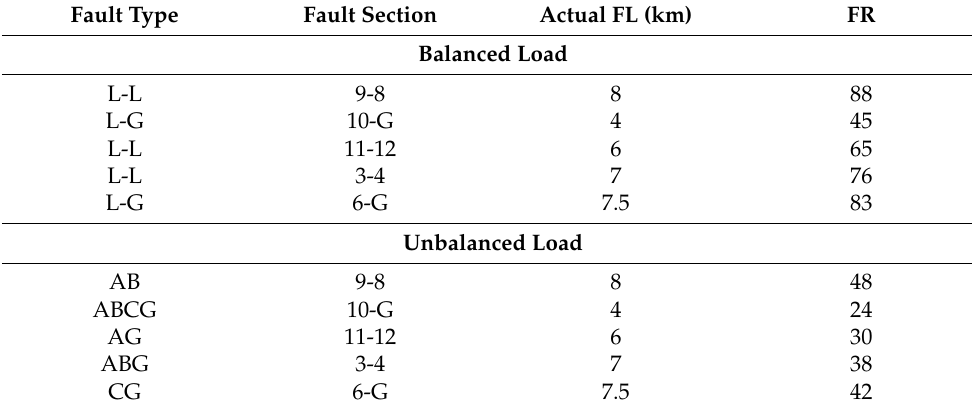
Table 5. Results of the different fault locations in